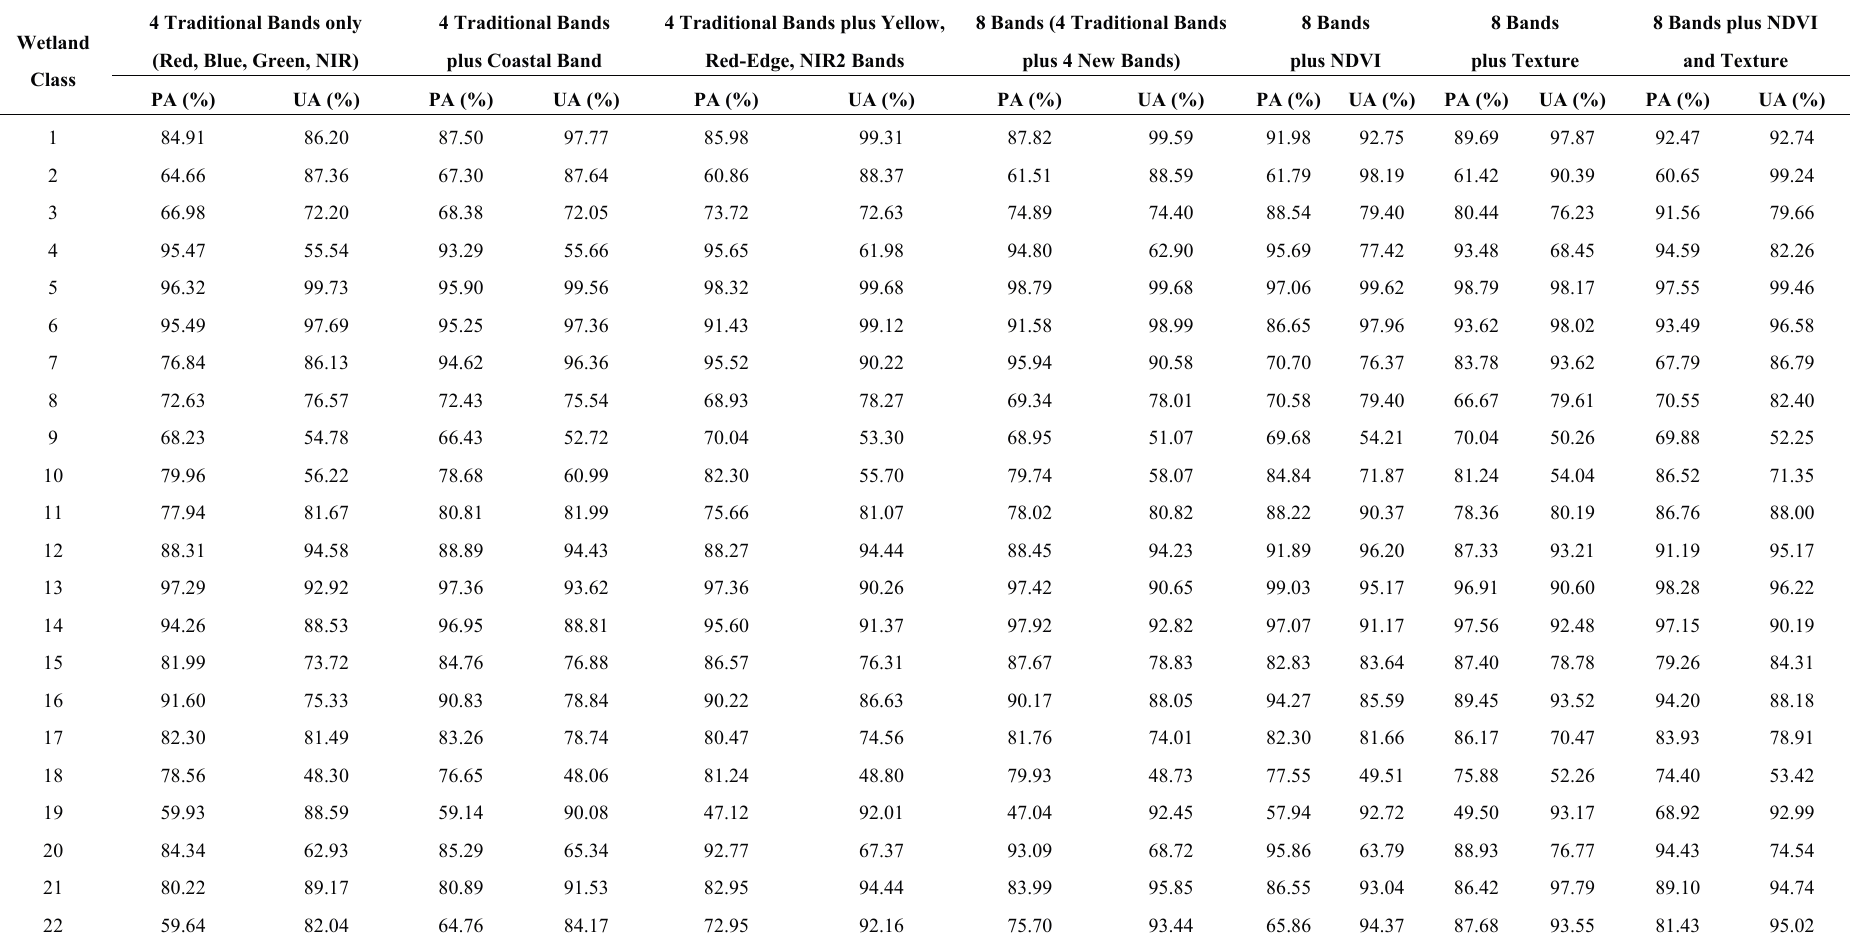
Table A1. Variation of classification accuracy with different combinations of WV2 spectral bands, NDVI, and texture for 22 classes of wetland and aquatic